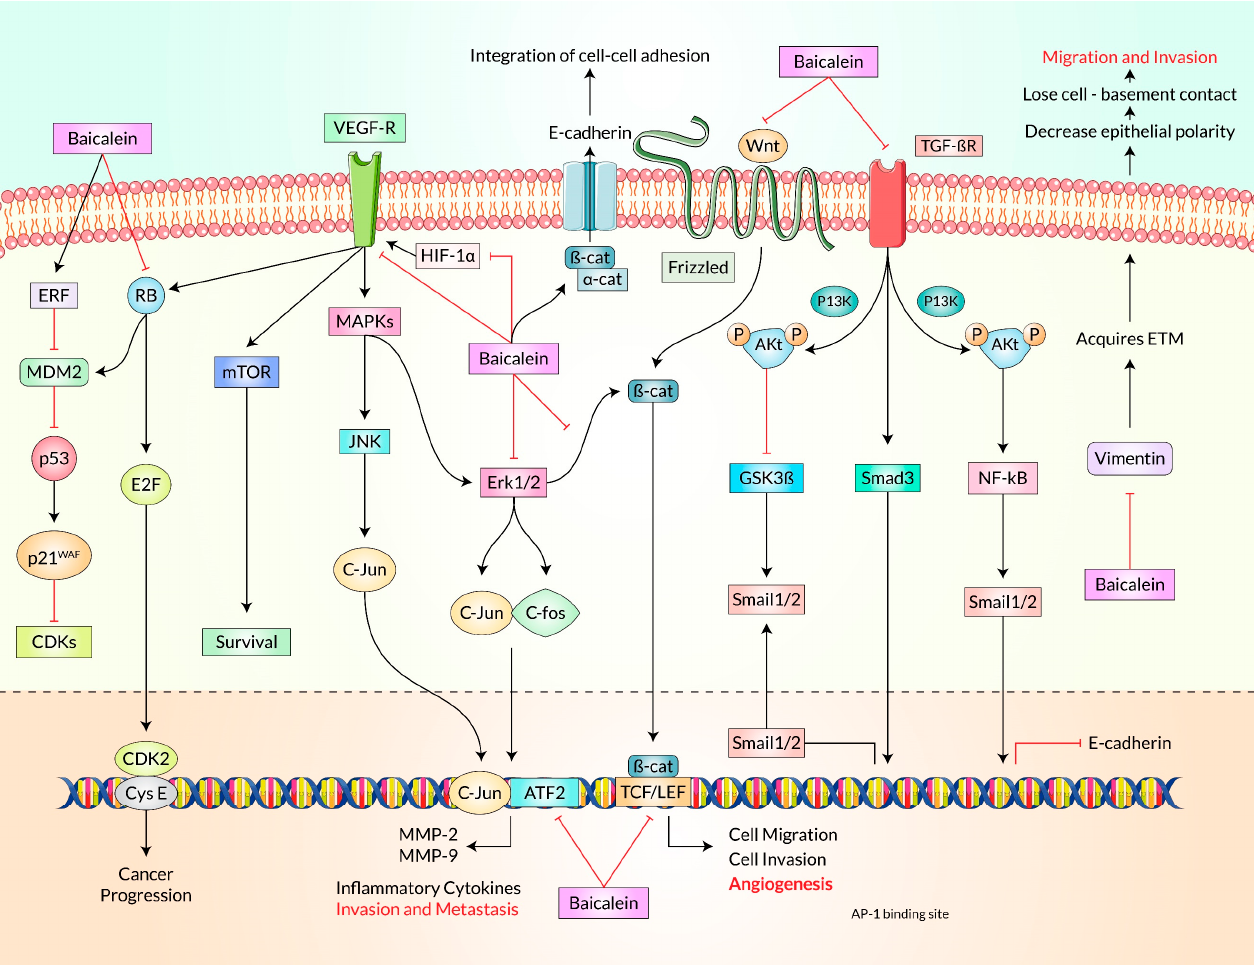
Figure 5. Mechanisms of Baicalein in regulating the cancer signaling pathways.